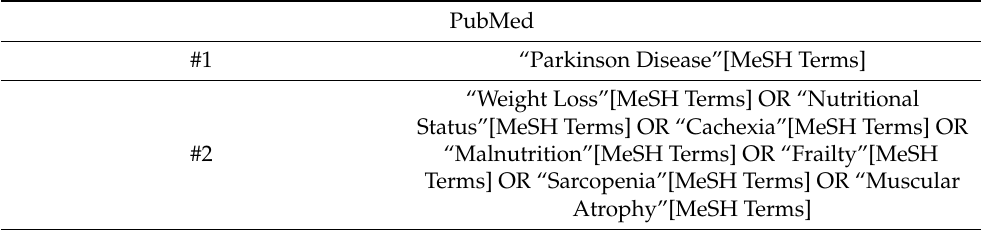
Table 1. Medical Science Heading (MeSH)